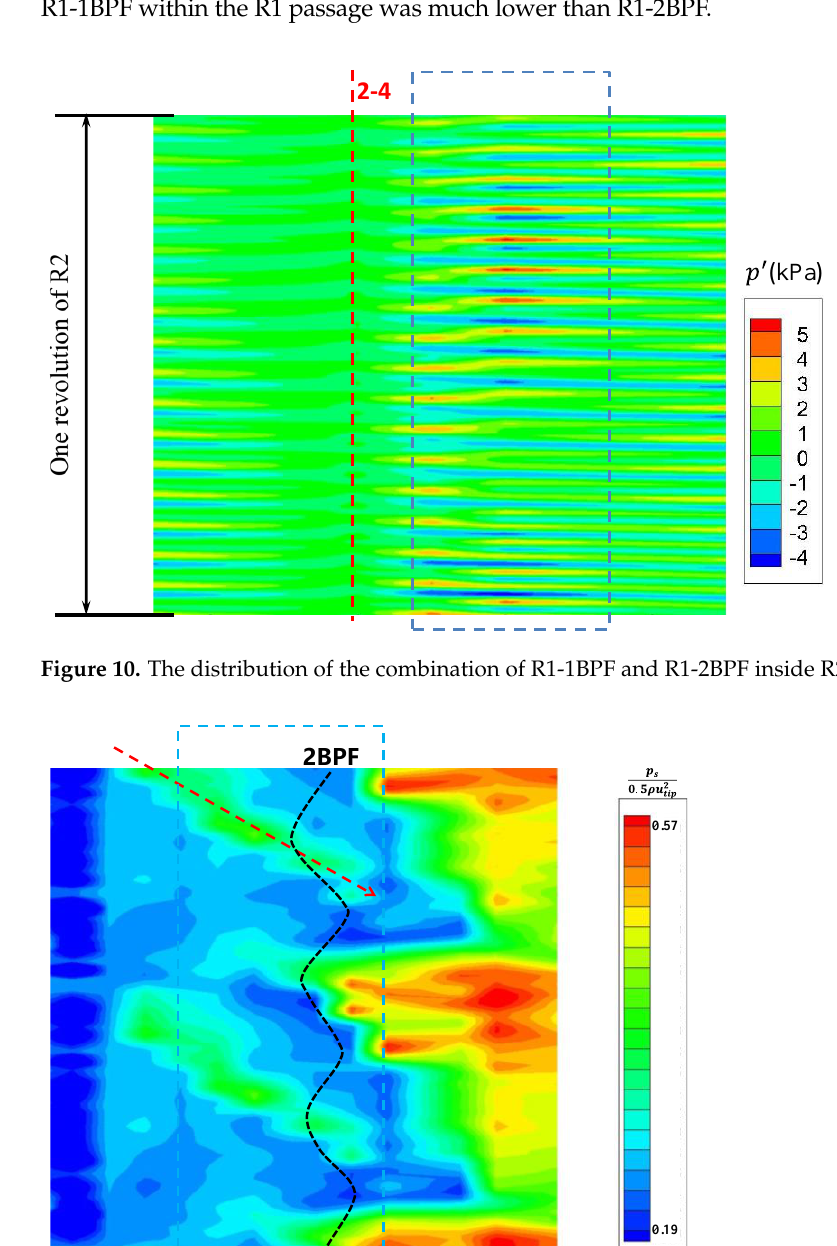
Figure 9. The propagation of the R1-2BPF disturbance within the R2 passage .